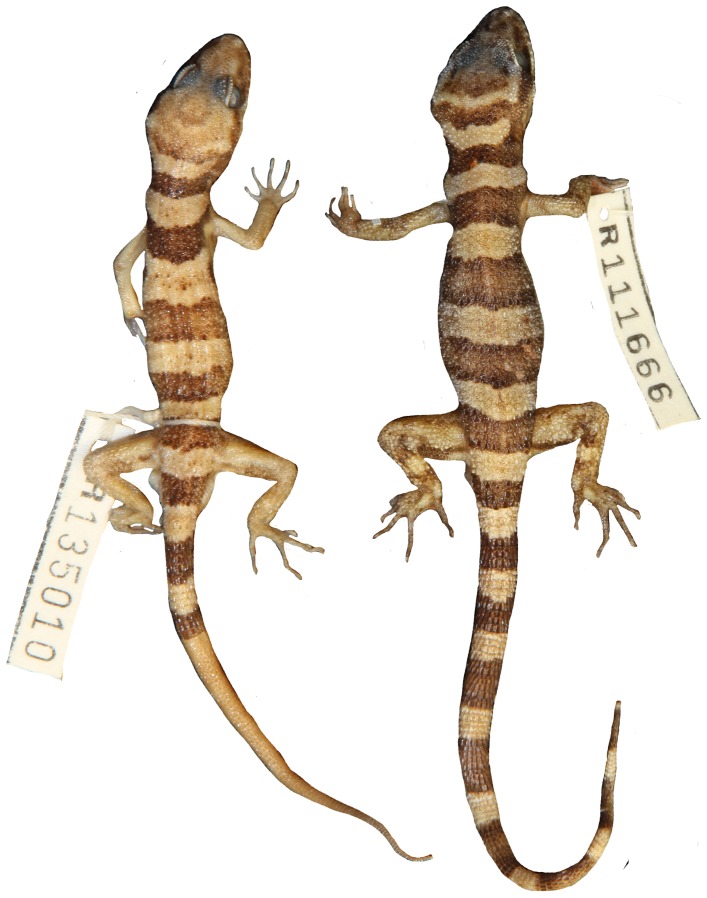
Dorsal pattern within Heteronotia spelea ‘south-eastern’.Note the occipital band of these individuals is in contact with the temporal stripe behind the eye, giving the appearance of an extra dorsal band (5 instead of 4).